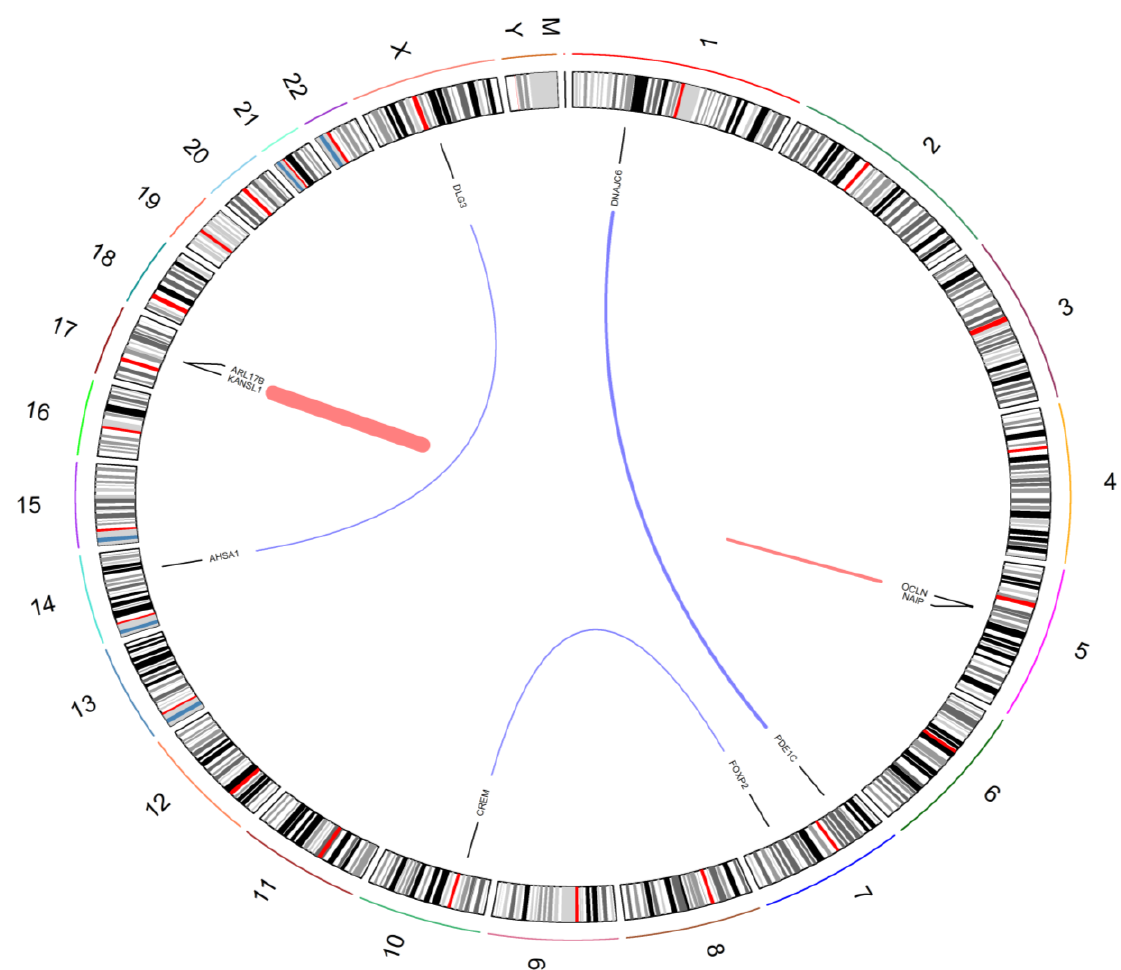
Figure 5. Chromosome Circos plot of novel fusion genes detected between fusion prediction tools. Red and blue lines indicate intra- and inter-chromosomal fusions. All chromosomes and cytoband information are denoted. The width of each link varies according to number of reads supporting the fusion event.